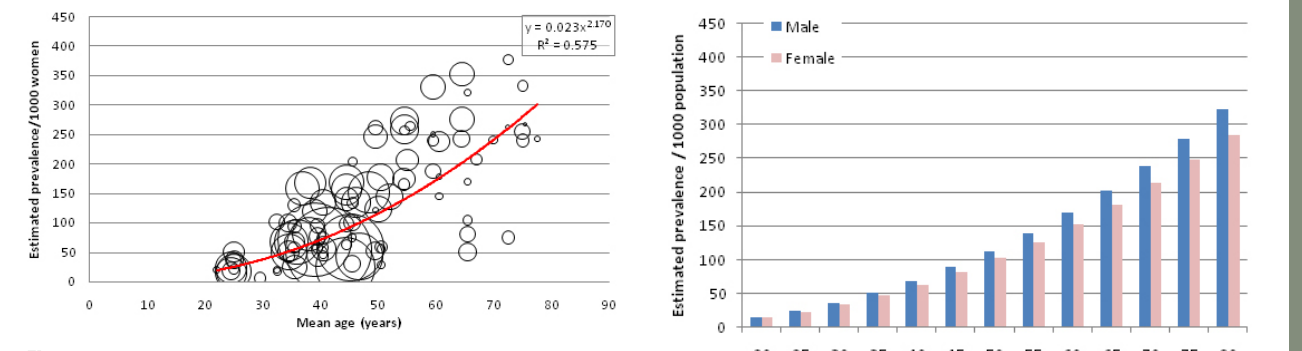
Figure 6. Relationship between crude prevalence of type 2 diabetes and age in Southern Asia in female examinees. Table 14. Female prevalence estimates for 2005